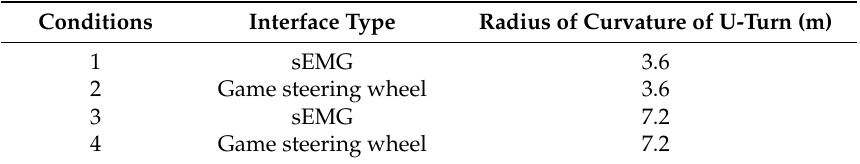
Table 1. Experimental conditions for driving